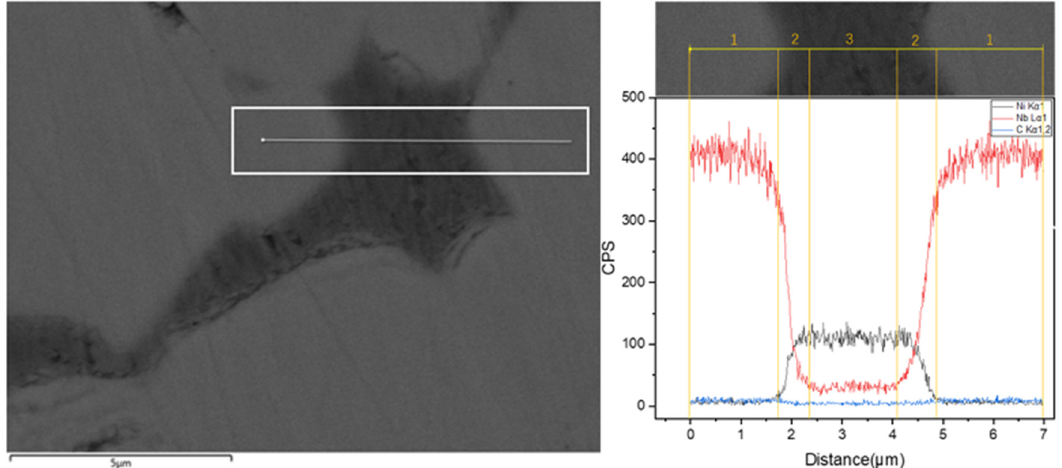
Figure 4: EDS line scanning of NbC – 12Ni interfacial boundary at